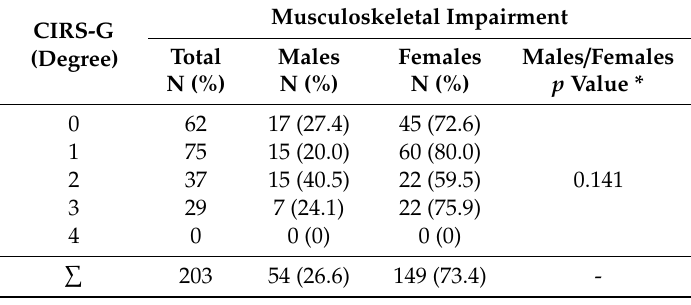
Table 1. Frequencies of comorbidities.